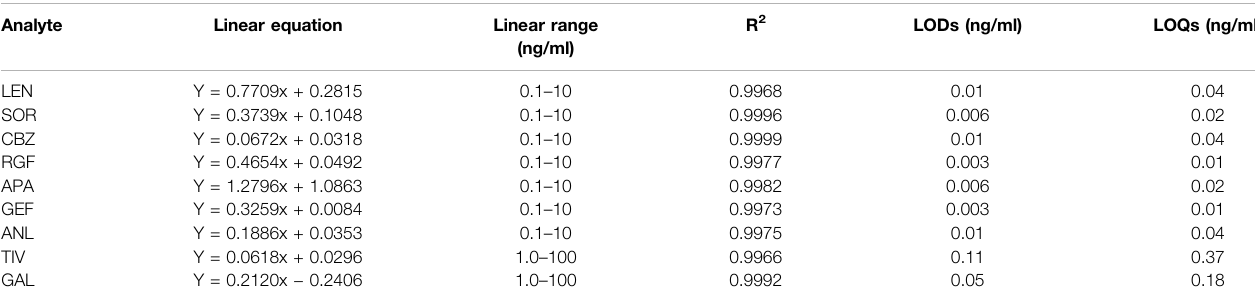
TABLE 2 | Linear regression equations, LODs, and LOQs of all TKIs. Analyte Linear